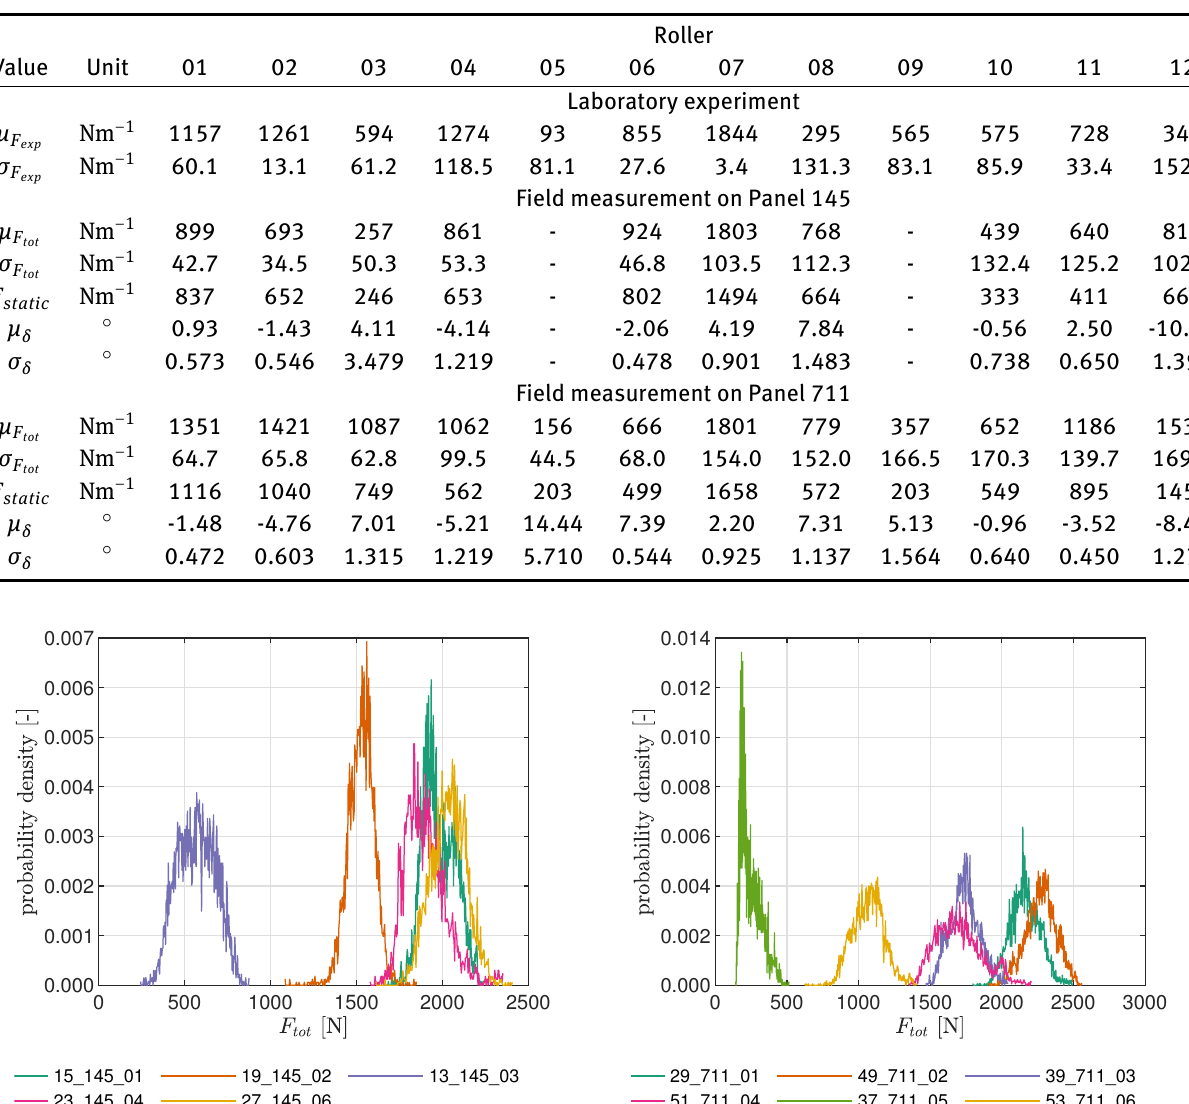
Table 2: Compendium of measured force on rollers. Forces are scaled to a 1.0m long belt element.